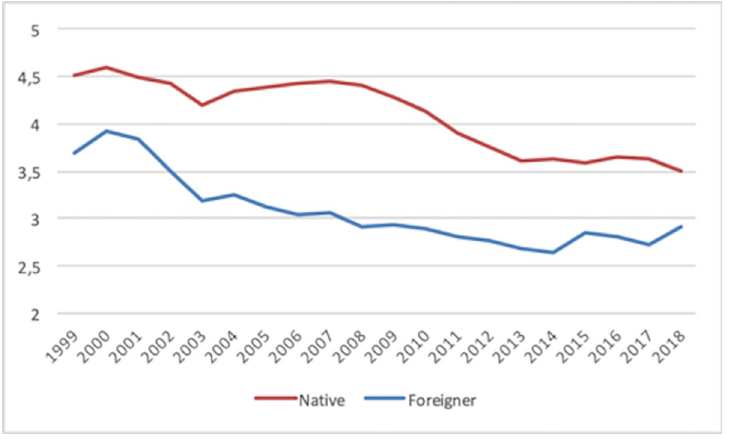
Fig 3. Self-employment rate (Employers) 1999–2018. Country